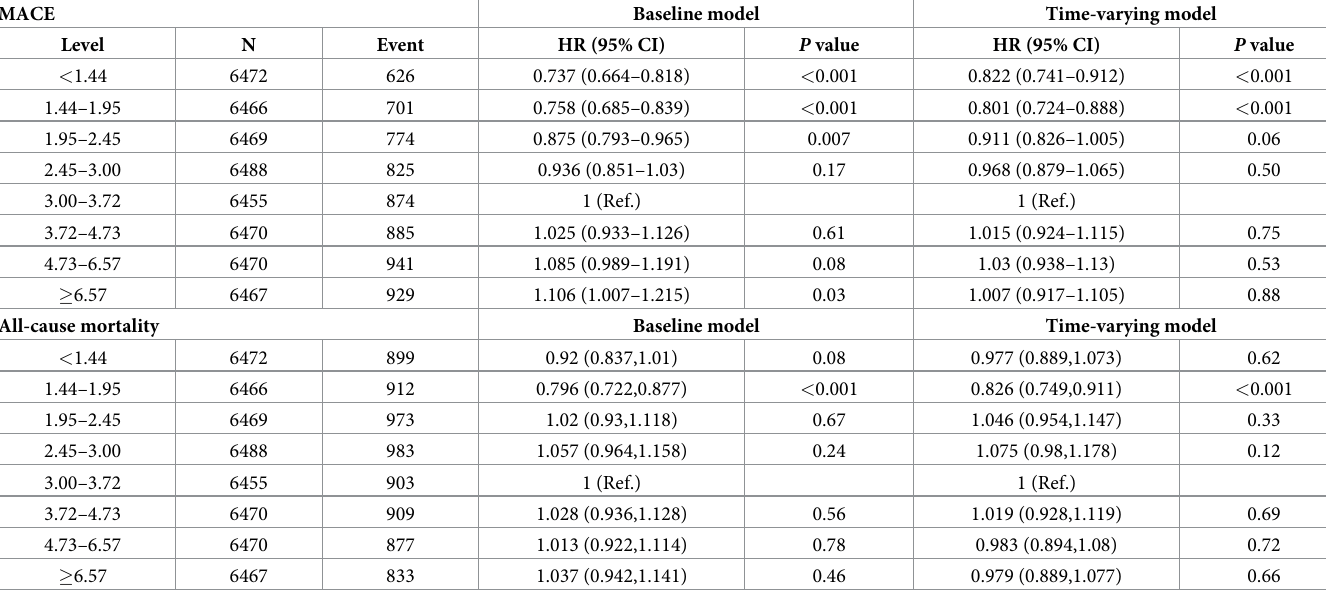
Multivariate adjustment, which adjusted for baseline characteristics of age, sex, BMI, smoking, systolic blood pressure, diastolic blood pressure, eGFR, urinary protein, serum hemoglobin and glucose